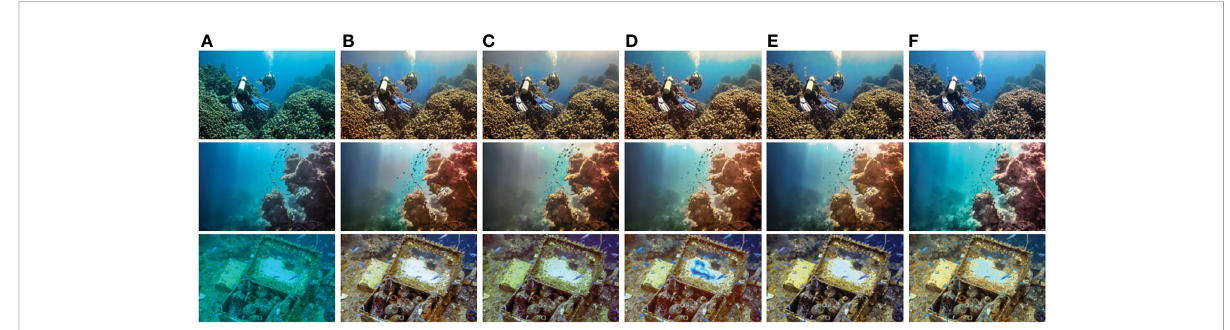
FIGURE 14 Visual comparisons of ablation experiments on RCAB and BN layers on UIEB datasets. Note: w/o RCAB indicates that the proposed model does not use RCAB, w/o CA indicates that the proposed model uses RCAB and does not use CA, w/o BN indicates that the proposed model uses RCAB and does not use BN. From left to right, (A) shows the raw underwater images, (B – E) are the results of w/o RCAB, w/o CA, w/o BN and the proposed model, respectively, and (J) shows the reference images.